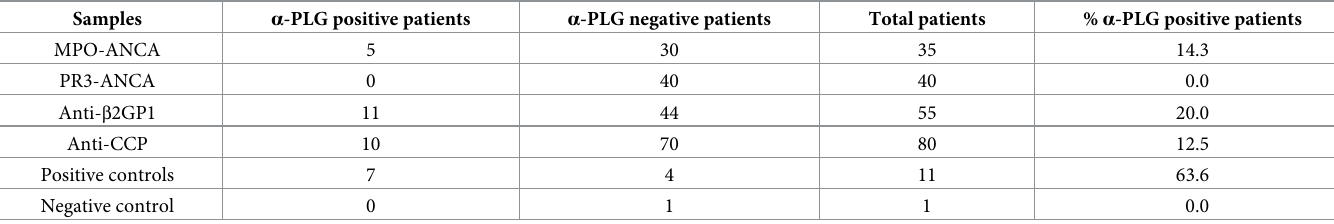
Table 1. Overview of anti-plasminogen antibody positive patients using our optimized assay.